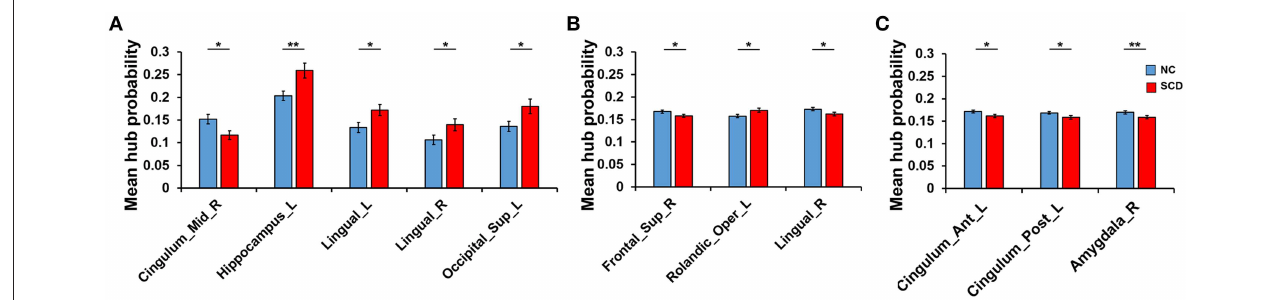
FIGURE 4 | Difference between groups at the different thresholds. Statistical significance: * p < 0.05; ** p < 0.01. (A) The absolute threshold (correlation efficient r = 0.2). The mean hub probability of five regions (right midcingulate area, left hippocampus, left and right lingual gyrus and left superior occipital) showed significant difference between NC (blue) and SCD (red) group. (B) The proportional threshold (sparsity = 0.2). Right superior frontal gyrus, left rolandic operculum, and right lingual gyrus showed significant difference. (C) The proportional threshold (sparsity = 0.25). Left anterior cingulate gyrus, left posterior cingulate gyrus, and right amygdala showed significant